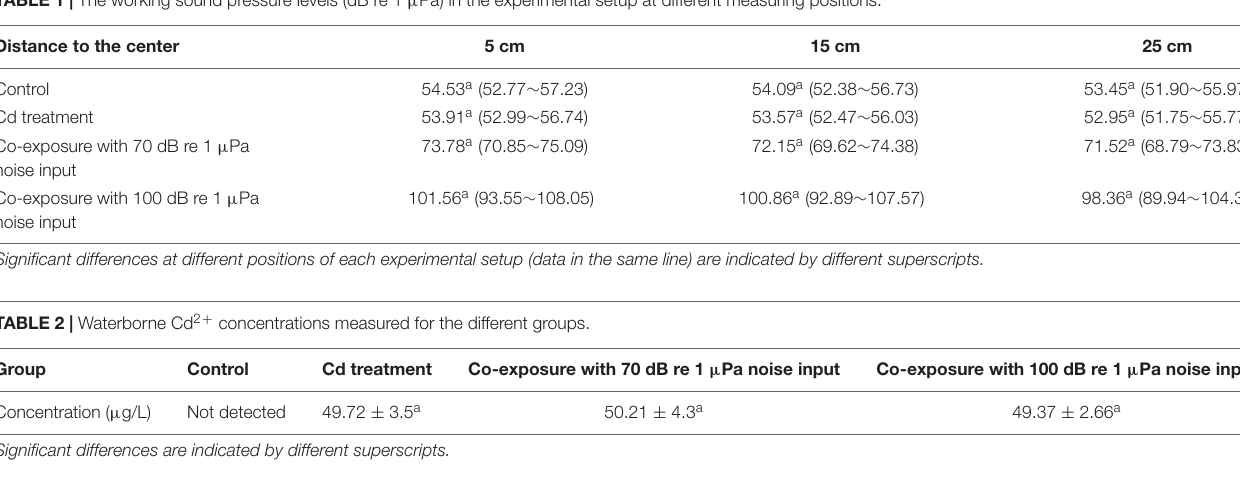
TABLE 1 | The working sound pressure levels (dB re 1 µ Pa) in the experimental setup at different measuring positions. Distance to the center